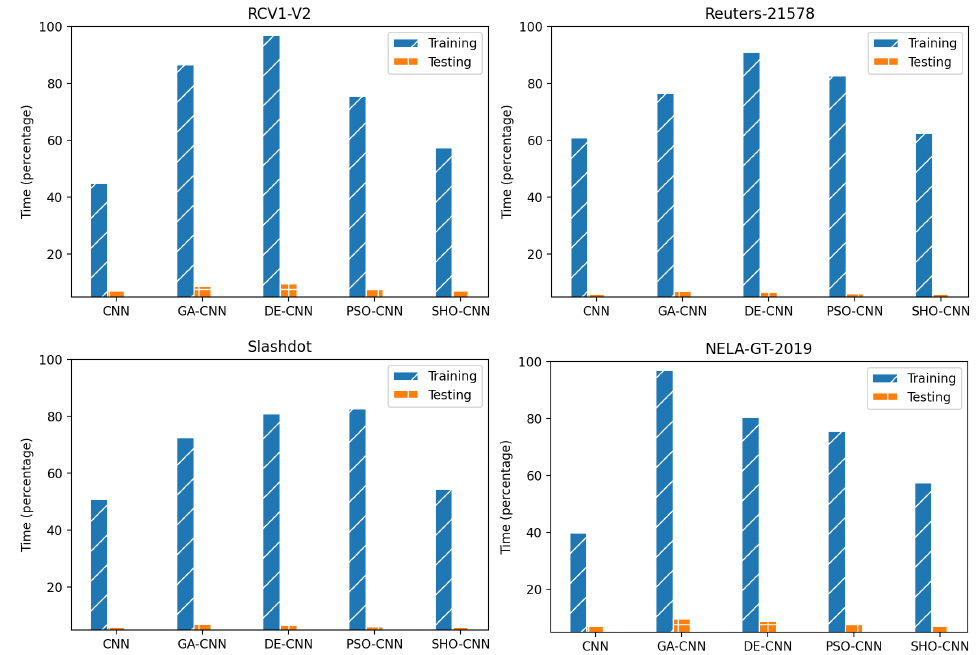
Figure 5. Evaluations based on execution